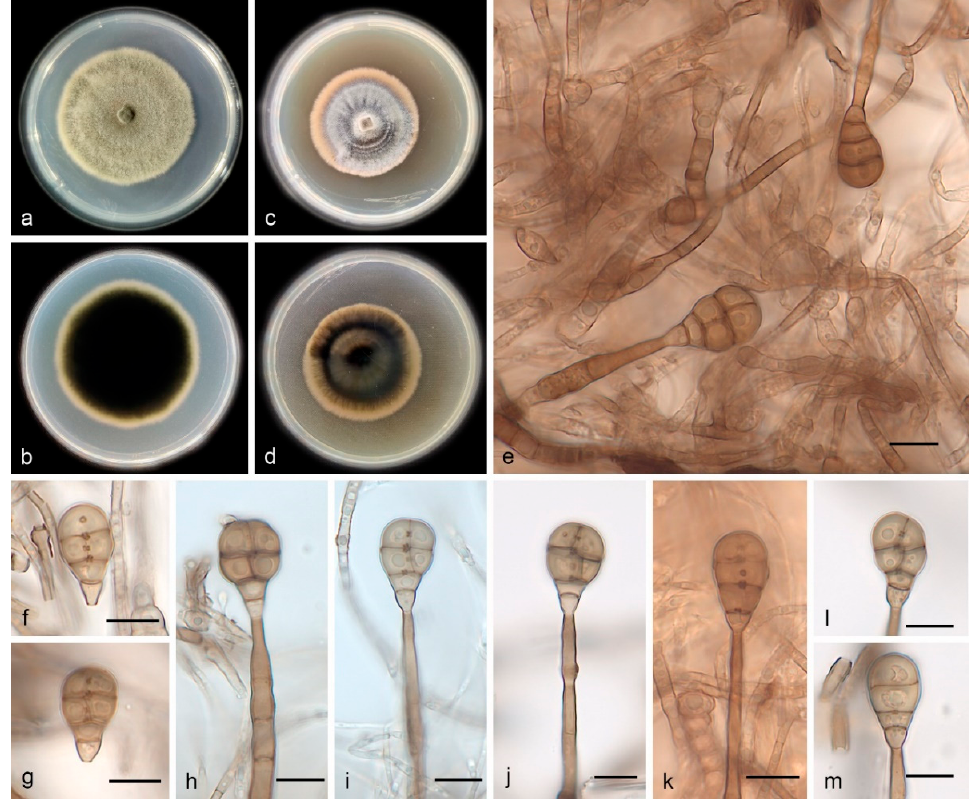
Figure 3. Acrodictys diaoluoshanensis (holotype HMAS 352235, ex-holotype SAUCC 1601): ( a , b ) surface sides of colony after incubation for 30 days on PDA ( a ) and MEA ( b ); ( c , d ) reverse sides of colony after incubation for 30 days on PDA ( c ) and MEA ( d ); ( e – m ) conidiophores, conidiogenous cells, and conidia. Petri dish diameter: 90 mm ( a – d ). Scale bars: 10 µ m ( e – m